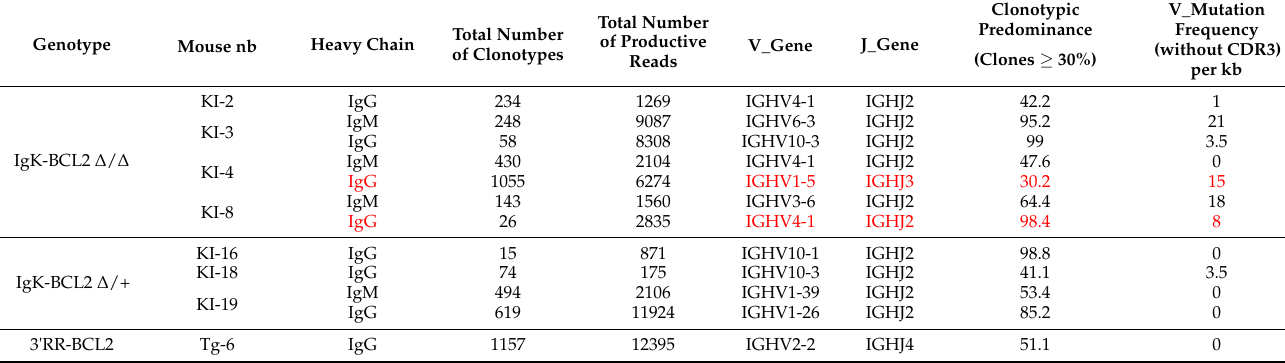
Figure 7. Tumors in BCL2 mice: ( A ) Curve showing the evolution of tumor occurrence in both BCL2 models with respect to their age (in weeks). ( B ) Immunohistochemistry (IHC) analysis of the spleen at the pre-tumoral and tumor-infiltrated stage of both BCL2 models compared to WT. Staining was performed for B cells (using B220 in Fitc ⟶ Green), plasma cells (CD138 in Tritc ⟶ Red), human BCL2 (in cyanine 5 ⟶ Yellow), and finally, DAPI in blue. Table 2. Mutation in the expressed V region of mouse tumor samples. Table showing the detailed IgM Table 1. Description of tumors: Table describing the mice that developed tumors in both BCL2 mod- and IgG repertoire analyses of the tumor tissues of mice from both BCL2 models. Total number of els. This cohort comprised 19 Ig κ -BCL2 (total), and 8 3 ′ RR-BCL2 mice were allowed to grow older, clones for each heavy chain and the corresponding number of productive reads are indicated. Based and these tumors were monitored for tumor development over time. For each mouse, the age at on the previous repertoire data obtained from WT mice, a certain threshold for the clone frequency which they developed the tumor (or pre-tumoral symptoms), along with a detailed description of was used, and only the clones that were present at a frequency higher than or equal to 30% were the location and the phenotype of each tumor, is listed. selected. For each clone, the V and J genes used along with their corresponding V mutation frequency (without CDR3 as it is highly mutated) are also